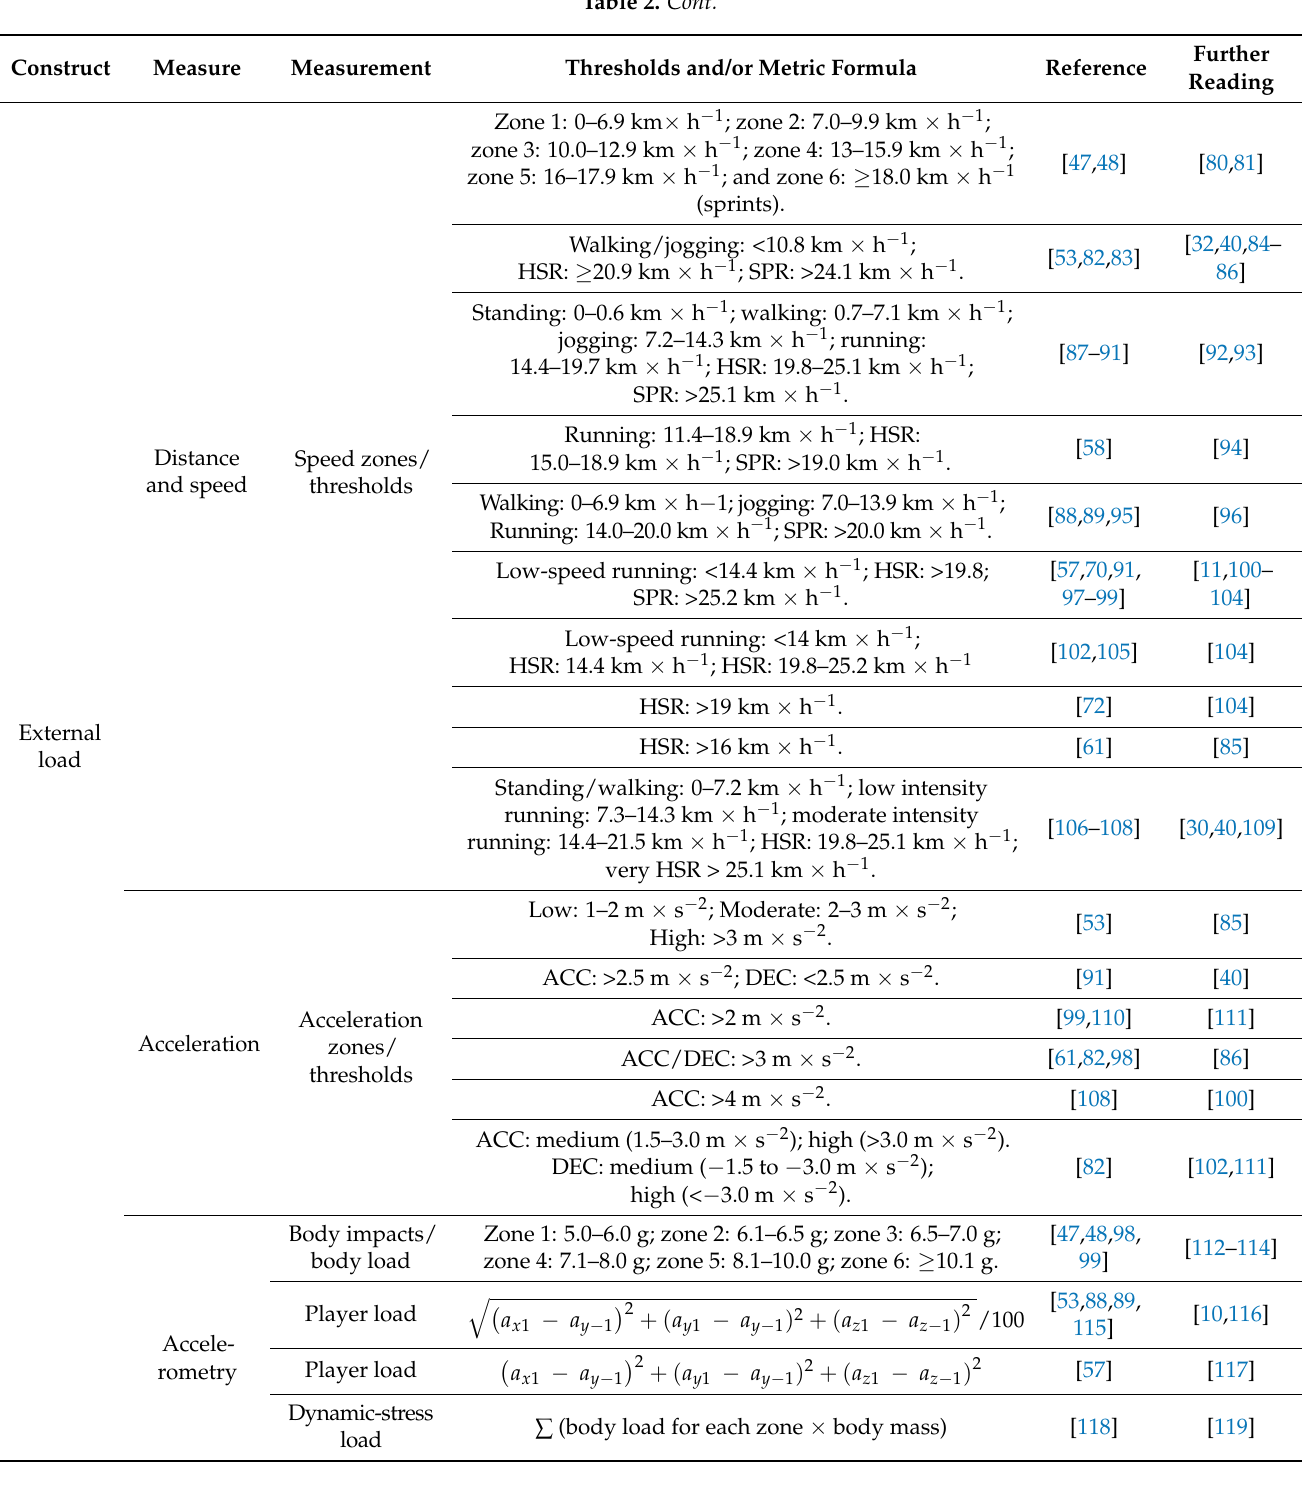
Table 2. Cont. Thresholds and/or Metric